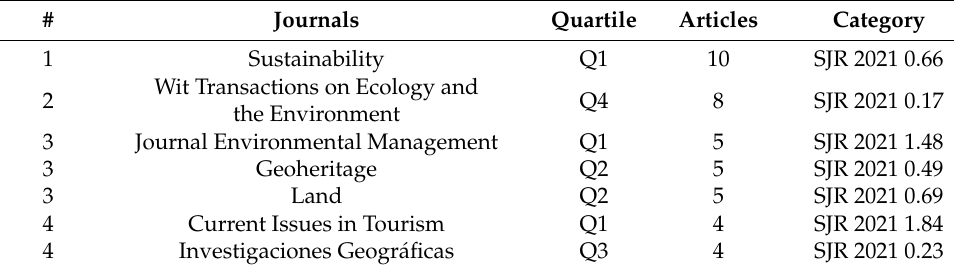
Table 2. Top 5 journals with the highest number of publications in the study